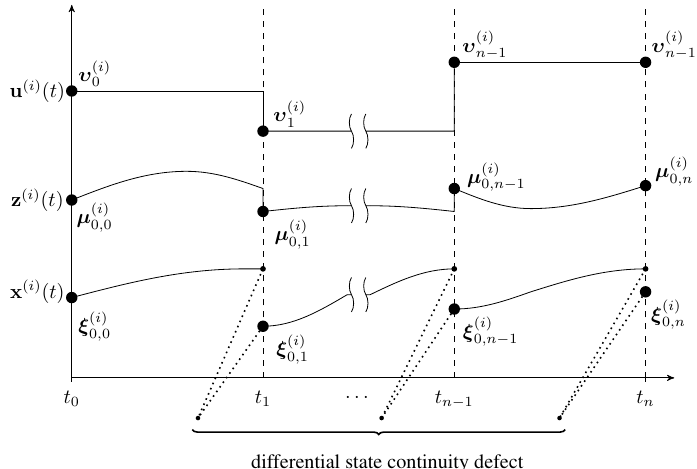
Figure 1. Multi-period multiple-shooting